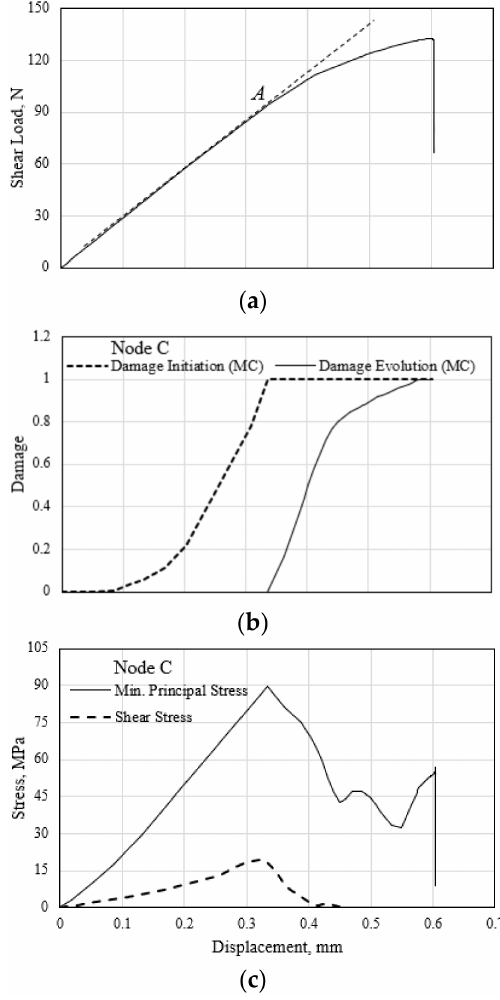
Figure 17. ( a ) Shear load–displacement response in the transverse direction. ( b ) Evolution of damage initiation variable and subsequent damage for the material point marked C in Figure 16b. ( c ) Evolution of stresses during the shear test of the HC